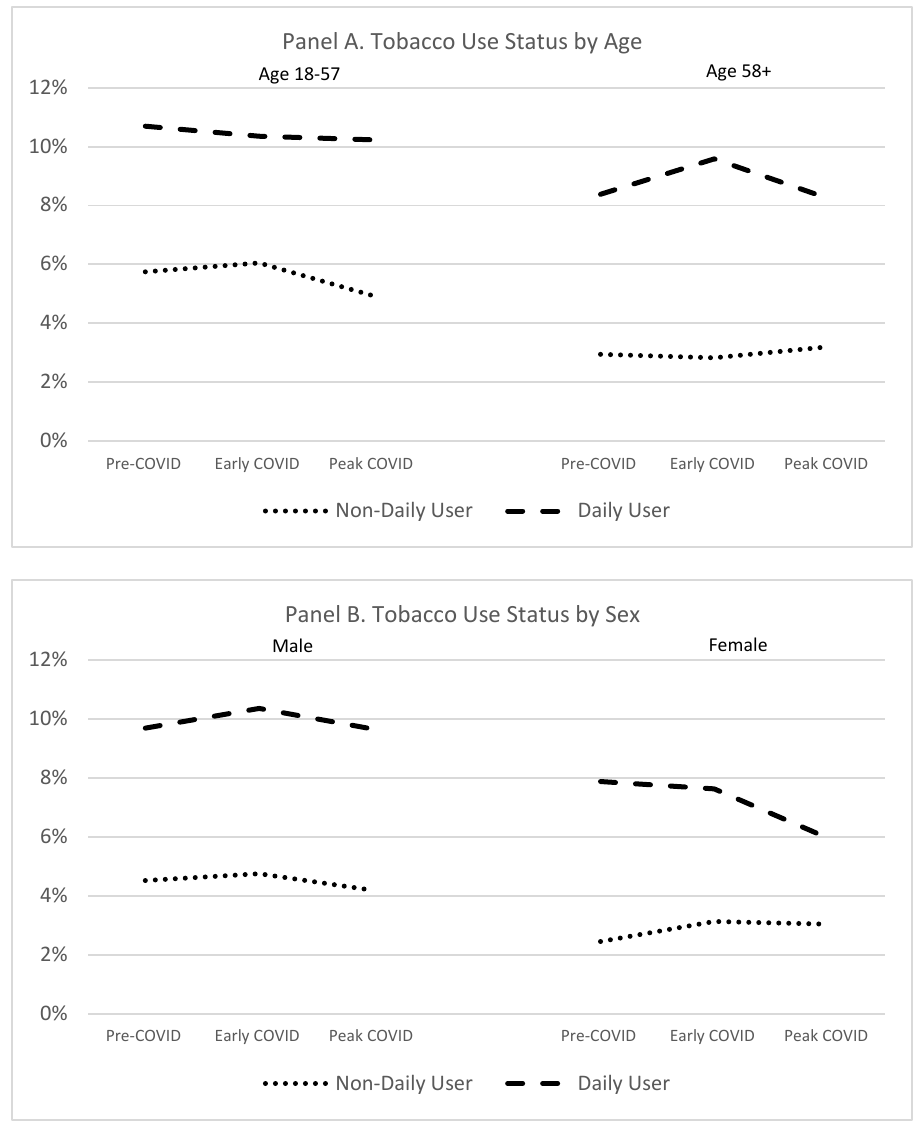
Figure 1. Tobacco use status over time for younger versus older ( Panel A ) and for male versus female ( Panel B ) Veterans.